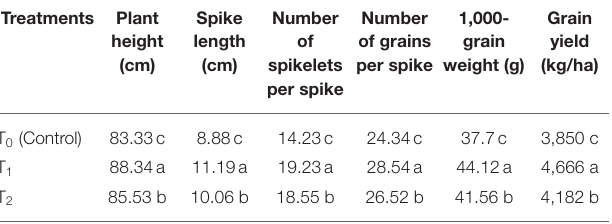
TABLE 2 | Effect of cytokinin (Ck)-producing A. brasilense RA − 17 (T 1 ) and non-producing A. brasilense RA − 18 (T 2 ) on plant height (cm) and yield parameters of wheat.